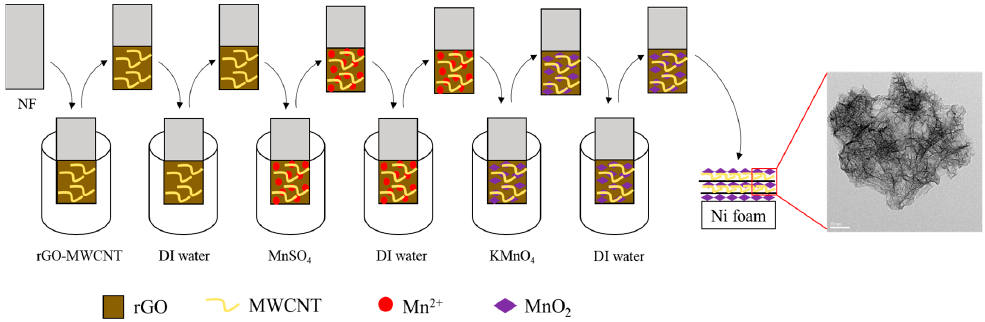
Figure 1. Schematic for the preparation of MnO 2 / rGO-MWCNT / NF electrode via the successive ion layer adsorption and reaction method.